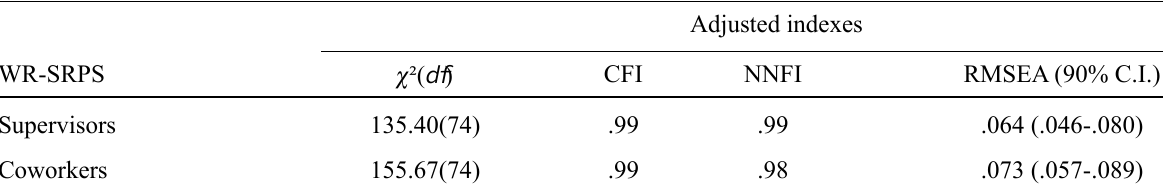
Maximum Likelihood Fit Indexes for WR-SRPS Supervisors and WR-SRPS